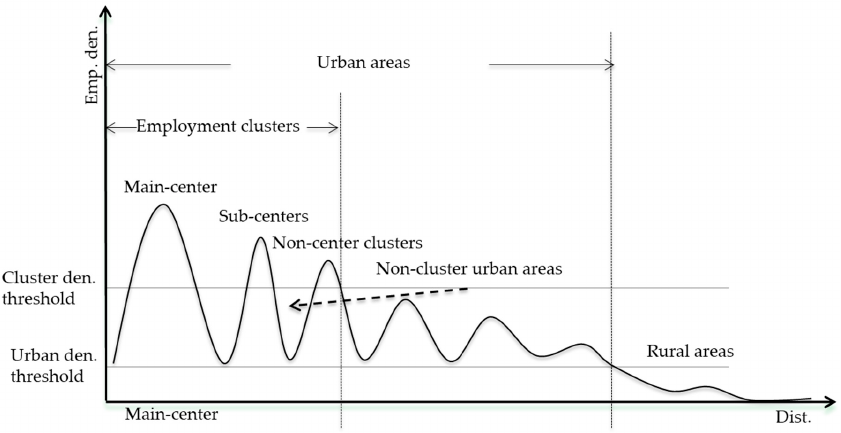
Figure 1. The definitions of a metro’s spatial constituents. (Note that the urban areas between the employment clusters are also non-cluster urban